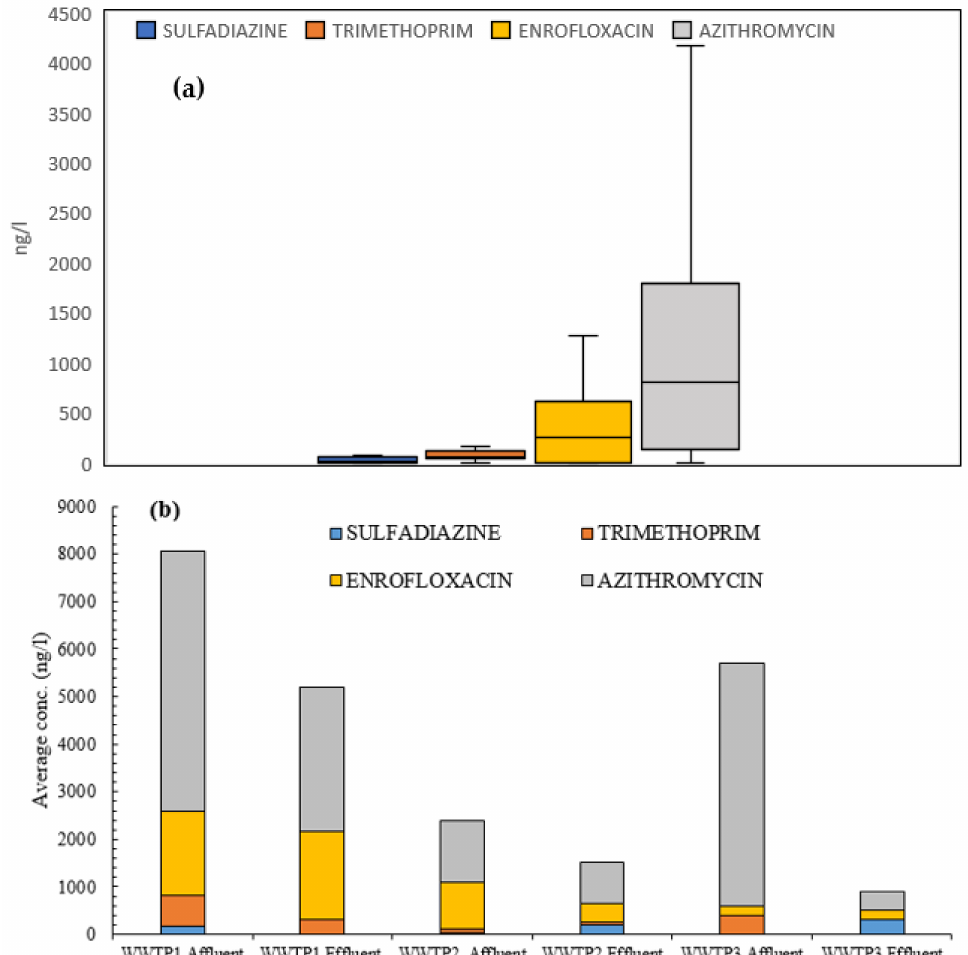
Figure 6. ( a ) Boxplots of selected antibiotics and ( b ) the average concentration of the target antibiotics in selected WWTPs (2018–2021) located in the Ebro River basin